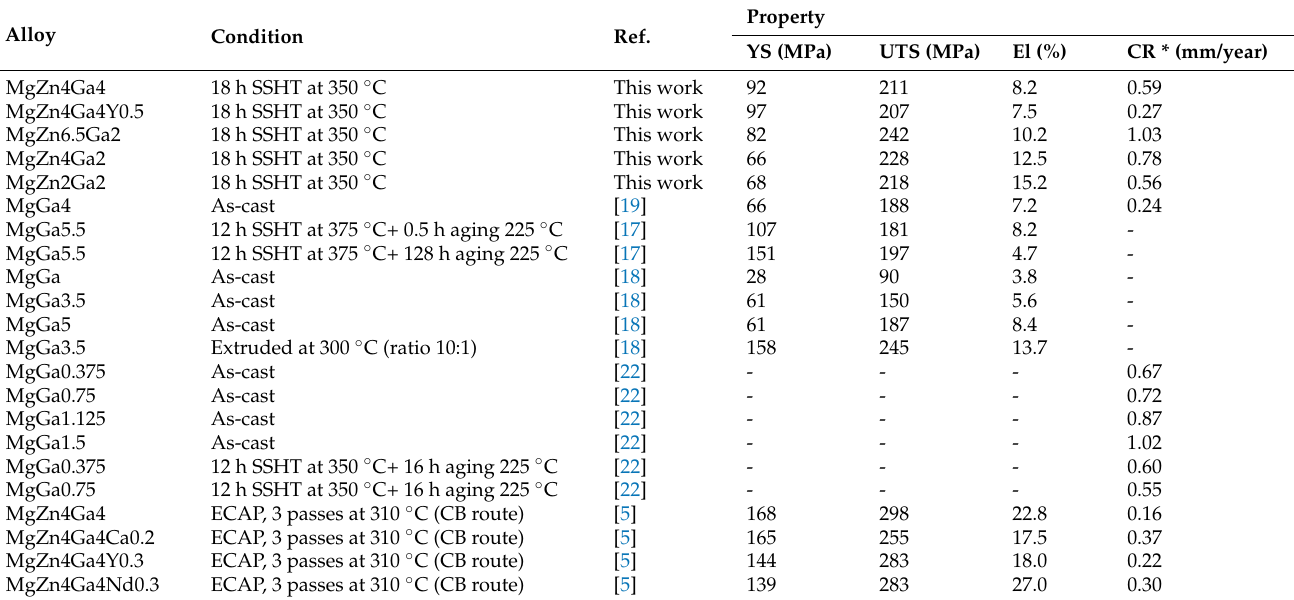
Table 3. Mechanical and corrosion properties of Mg alloys with Ga